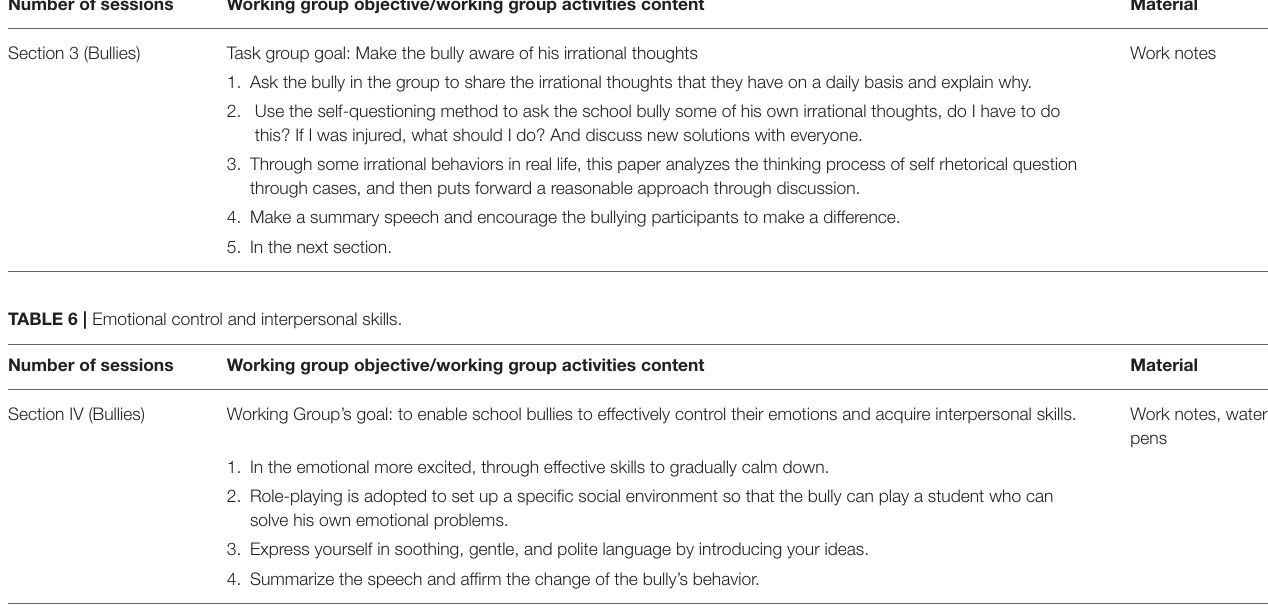
TABLE 5 | The unrational behavior courses for understanding the bullying self. Number of sessions